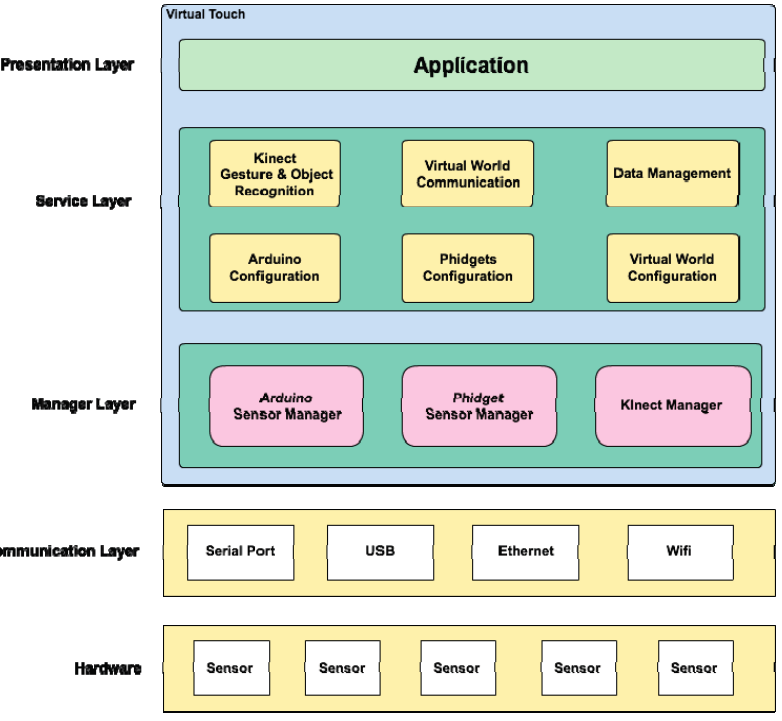
Figure 4. Virtual Touch Software